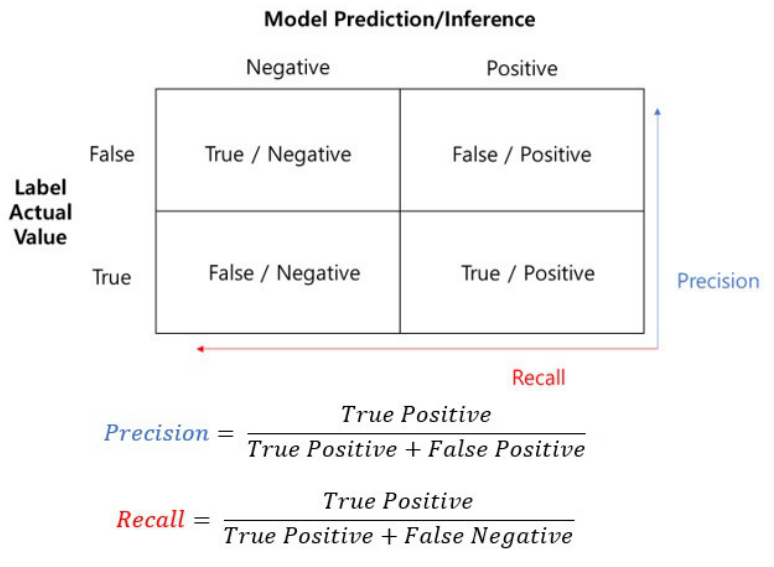
Figure 7. The confusion